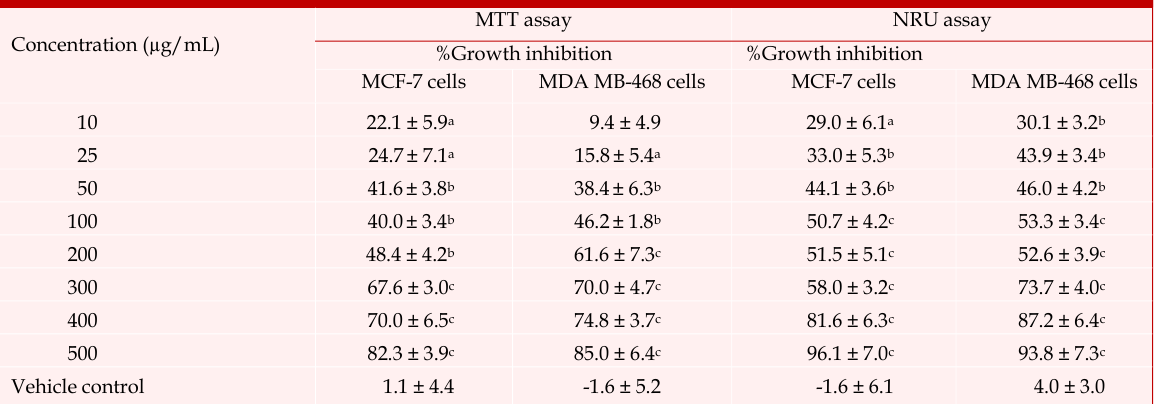
Dose-dependent growth inhibition of cancer cell lines by crude extract of Gaultheria trichophylla MTT Concentration (µg/mL)